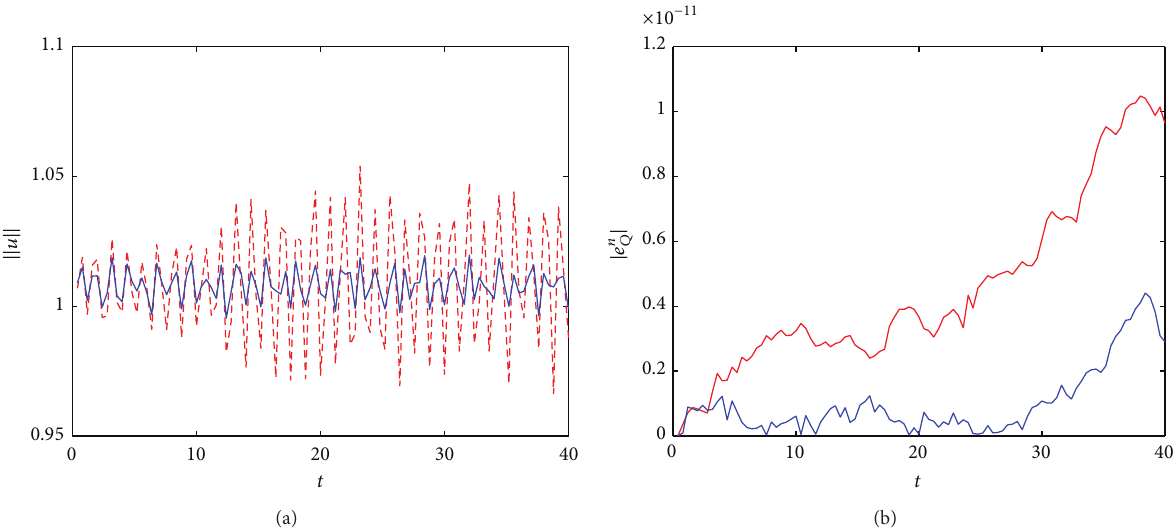
Figure 5: ‖𝑢‖ ∞ for one trajectory and the average norm over 50 trajectories (a). Residuals of discrete charge for one trajectory (b).